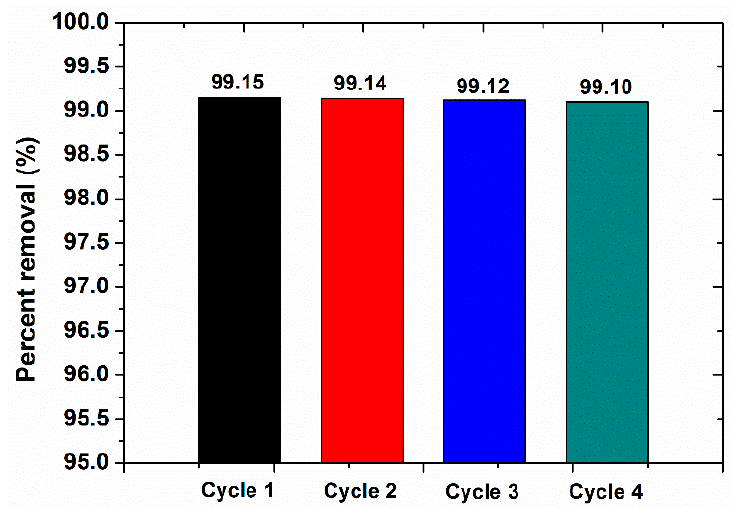
Figure 6. Catalyst reuse performance in the combined process with TiO 2 and Fe-zeolite catalyst after 20 min and 4 wash–dry reuse cycles.